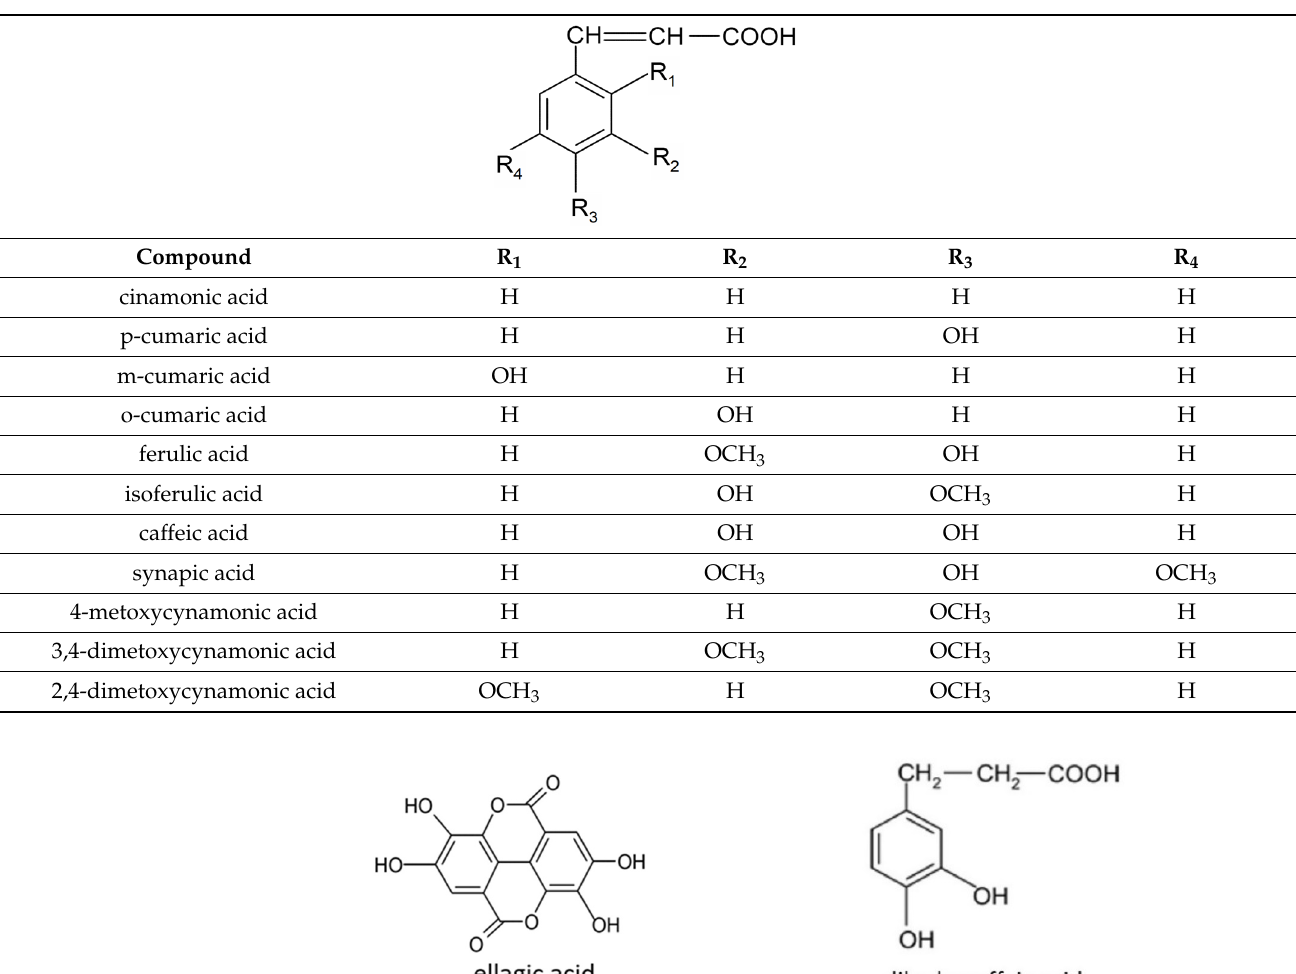
Table 4. Structural formulas of selected cinamonic acid derivatives.